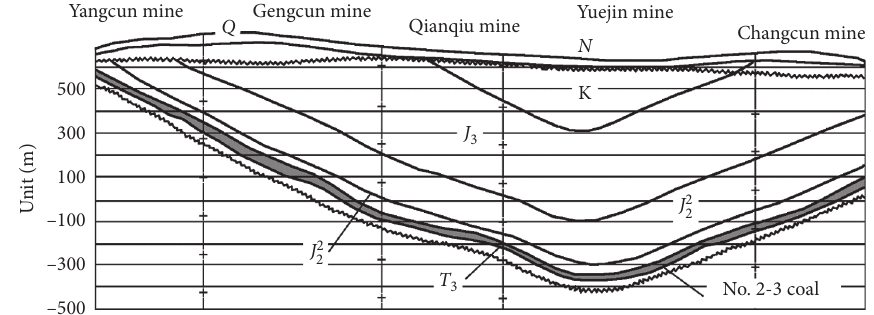
Figure 2: Geological profile of Yima coalfield.